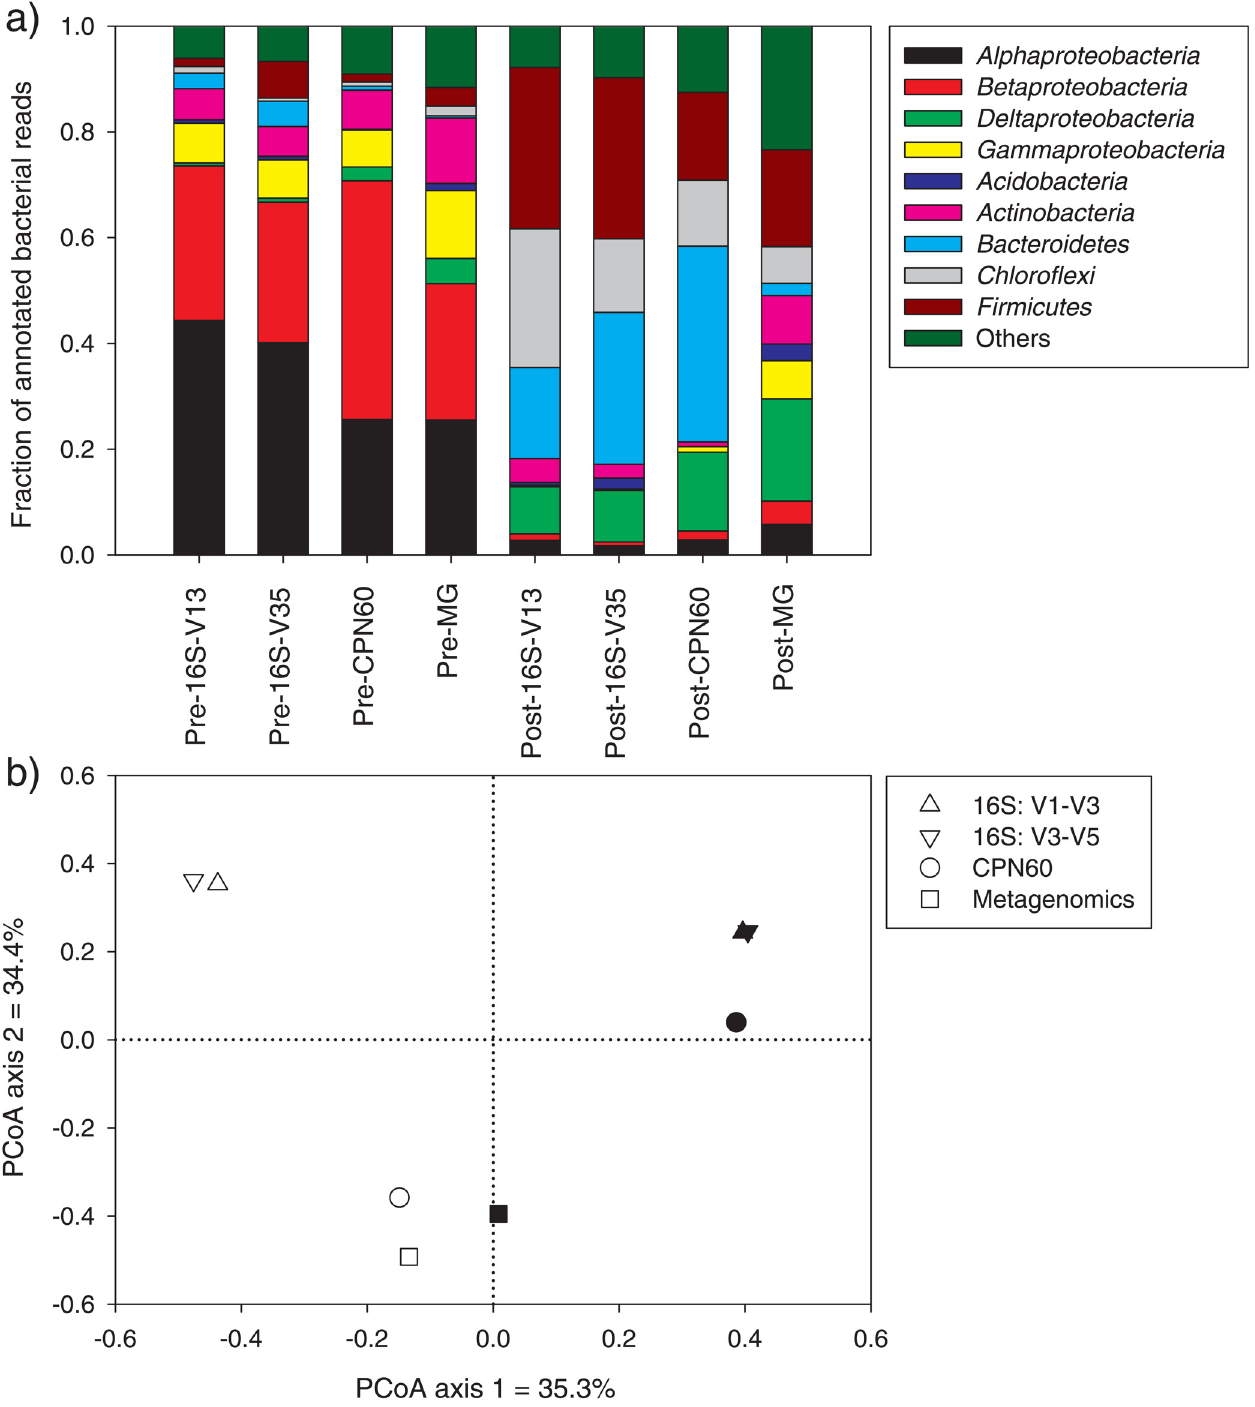
Fig 2. Bacterial phylum-level community composition (a) and genus-level principal coordinate analysis (PCoA) ordination (b) for 16S rRNA gene sequencing of the V1 – V3 and V3 – V5 regions, cpn60 gene sequencing and shotgun metagenomic sequencing for pre- and post-treatment biosolid sampled at Plant A on August 4, 2009. Solid symbols: pre-treatment, empty symbols: post-treatment.